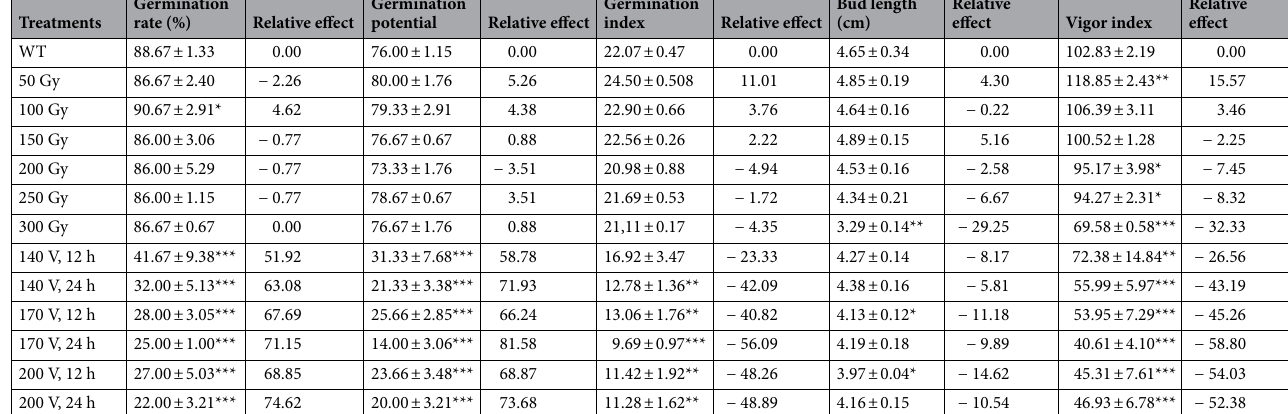
Table 3. Effects of γ-irradiation and DC electrophoresis bath mutagenesis on seed viability across the different treatments. Data are expressed as mean ± S.E. * p < 0.05, ** p < 0.01, and *** p <